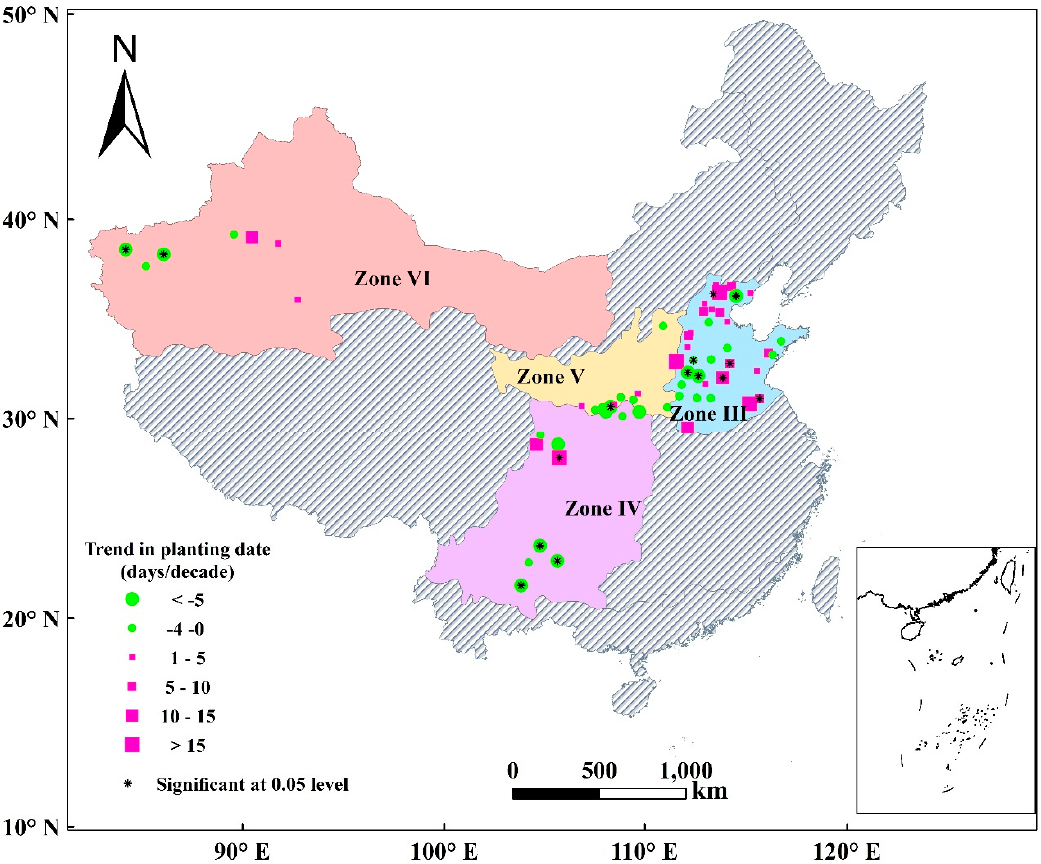
Figure 6. Trend in summer maize planting dates during the period of 1992 to 2010 at 64 agricultural meteorological experiment stations across China. The stations with trends significant at 0.05 level was marked by an asterisk.